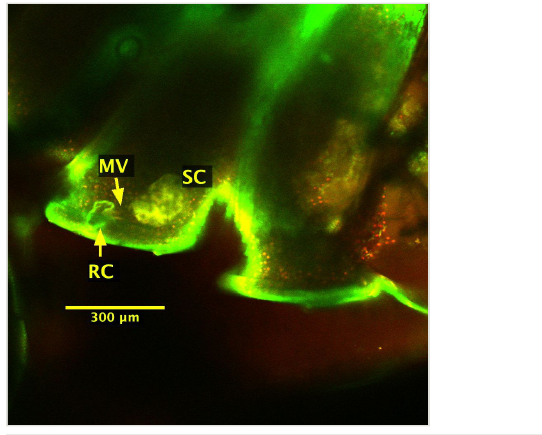
Figure 4. Top/rotated view of the juvenile millipede. SC = storage chamber, RC = reaction chamber, MV = muscularized valve connecting the two